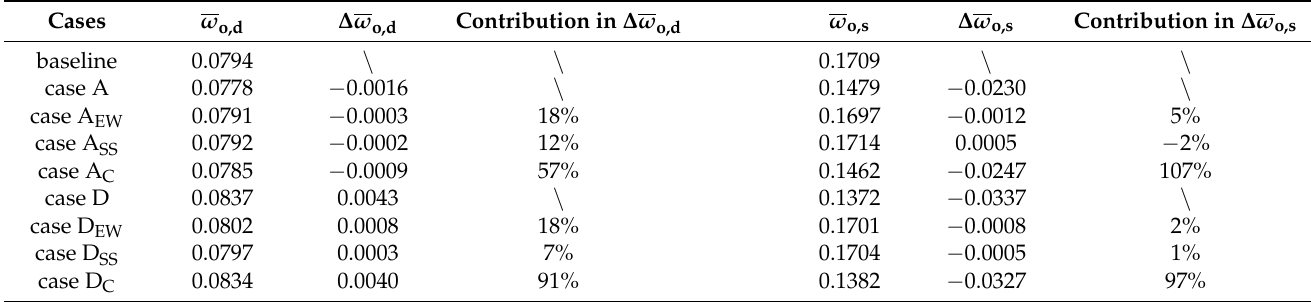
Table 1. The quantitative analysis of the partial profiling